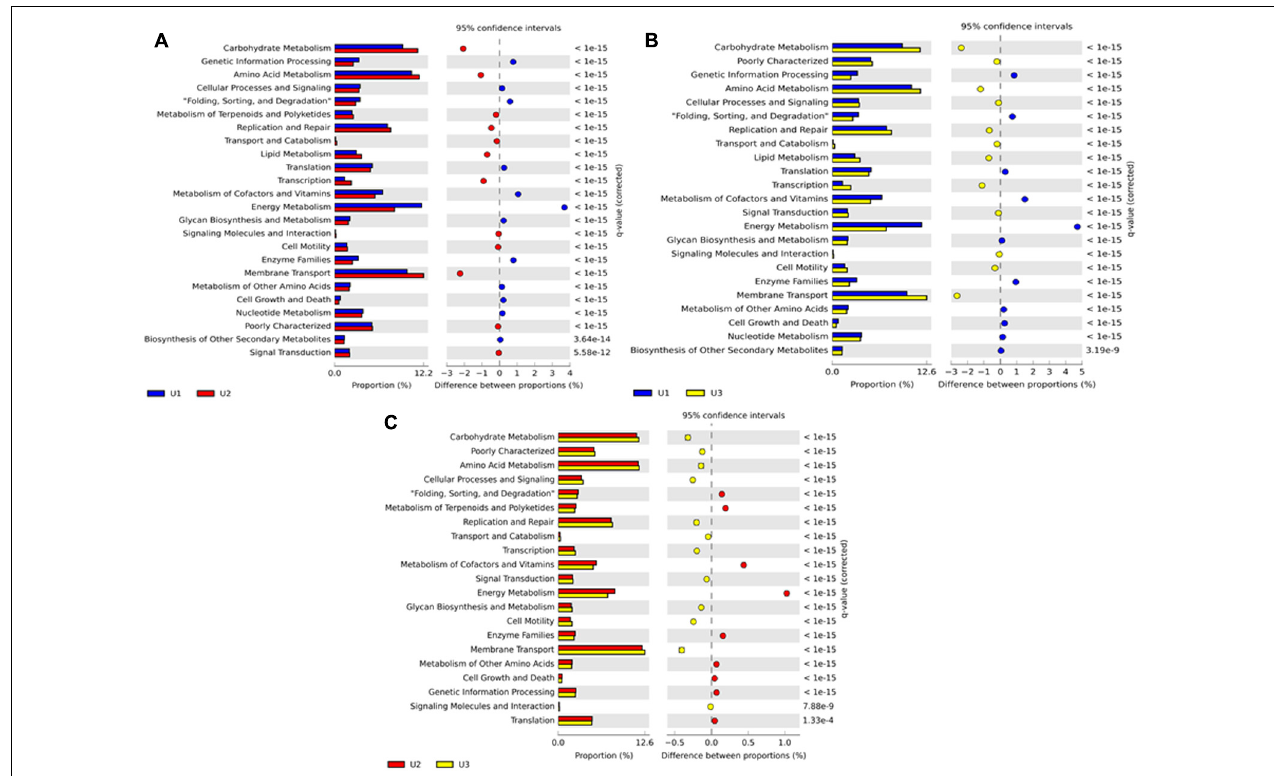
FIGURE 6 | Stacked column bar graph representing the predicted metabolic attributes compare between (A) U1 and U2; (B) U1 and U3; and (C) U2 and U3 laminae of a large conical mat from Lake Untersee, Antarctica. All sequence reads were used to predict functions against the KEGG database (http://www.genome.jp/kegg/), which is implemented in PICRUSt (http://picrust.github.io/picrust/) bioinformatics software package. The mean Nearest Sequenced Taxon Index (NSTI) value for all three laminae was 0.11 ± 0.017